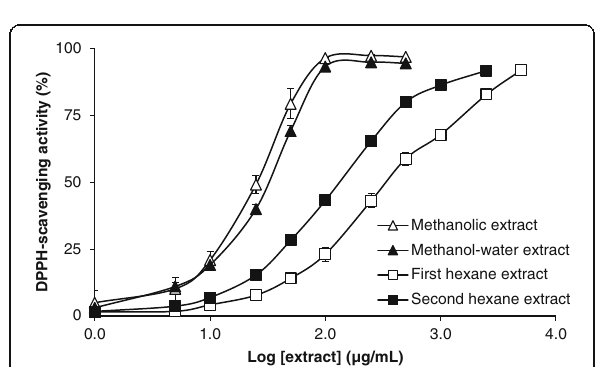
Fig. 3 Free radical-scavenging effects of T. carbonaria cerumen extracts, measured using a colorimetric assay (mean ± SEM). Following multi-solvent extraction of the methanolic extract, the methanol-water cerumen extract scavenged DPPH with greater potency than the first and second hexane extracts ( P < 0.05; n =